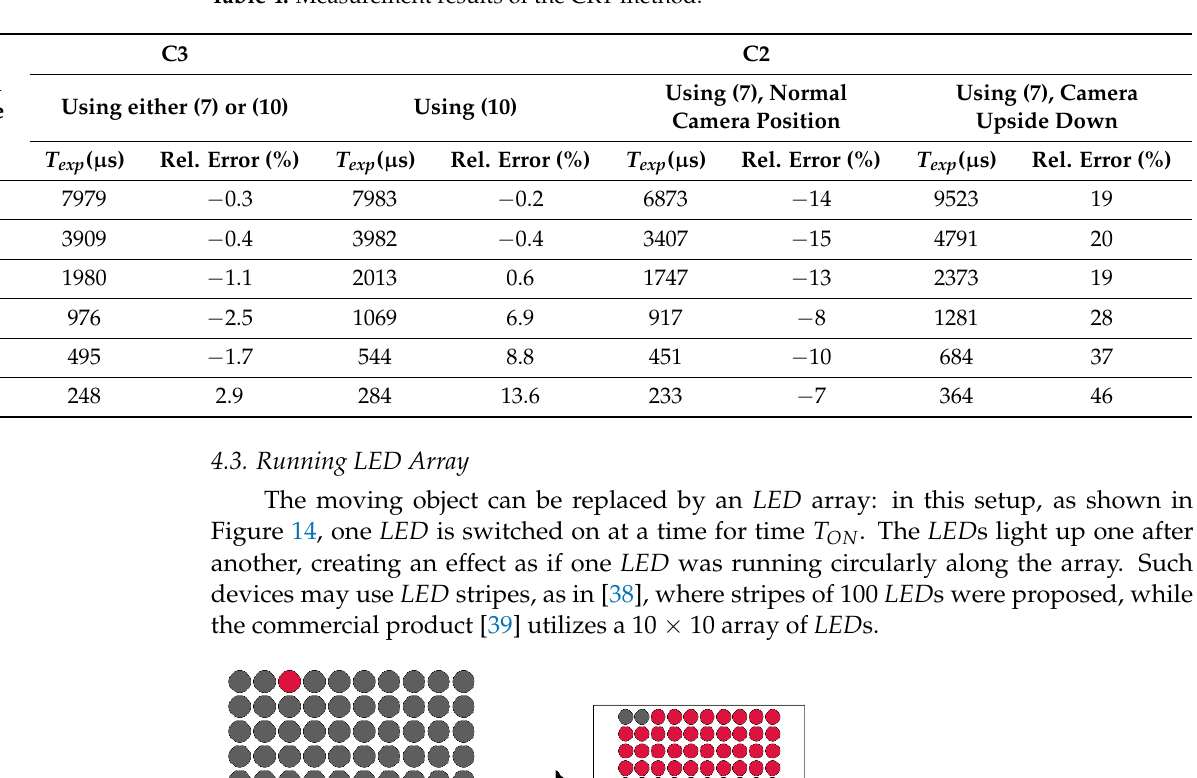
Table 4. Measurement results of the CRT method.